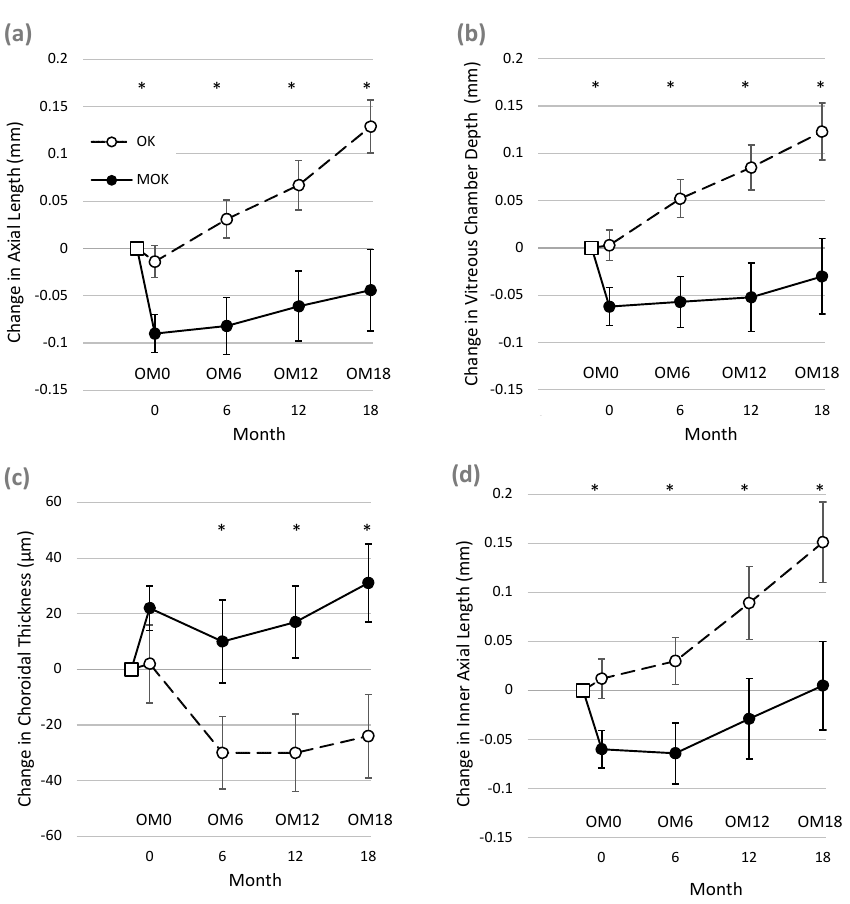
Figure 2. Changes in ocular dimensions during the study in eyes fitted with MOK lenses (solid lines and symbols) and eyes fitted with conventional orthokeratology (OK) lenses (dashed lines and open symbols). In each panel, the open square symbol represents baseline, and OM0, OM6, OM12, and OM18 indicate when outcome measures were taken. Changes over time in ( a ) axial eye length (AL), ( b ) vitreous chamber depth (VCD), ( c ) choroidal thickness (ChT), ( d ) inner axial length (IAL: posterior cornea to anterior sclera). * indicates significant difference in values for MOK and OK-treated eyes, ( p < 0.05; repeated-measures general linear model with Bonferroni post-hoc correction ( a , b , d ) or Wilcoxon signed-rank test ( c )). Error bars show ± 1 S.E.M. Mean short-term treatment differences (BL to OM0) were as follows: AL = − 0.076 mm (95% CI − 0.197 to − 0.043 mm, p = 0.00016); VCD = − 0.065 mm (95% CI − 0.0820 to − 0.035 mm, p = 0.00019); and IAL = − 0.081 mm (95% CI − 0.099 to − 0.032 mm, p = 0.0003). The data for ChT did not follow a normal distribution, but pairwise comparisons of ChT between MOK and OK eyes using the Wilcoxon signed-rank test showed no signif- icant difference between ChT change in OK and MOK eyes at time OM0 (difference = 0.019 ± 0.07 mm, p =